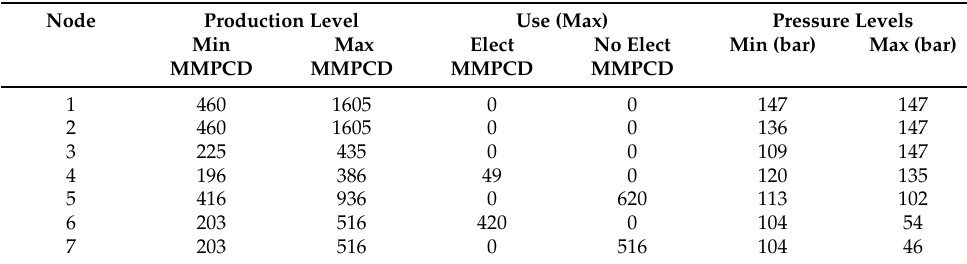
Table 6. Maximum and minimum flows considering electric and non-electric demands (adapted from Osinergmin) [27].